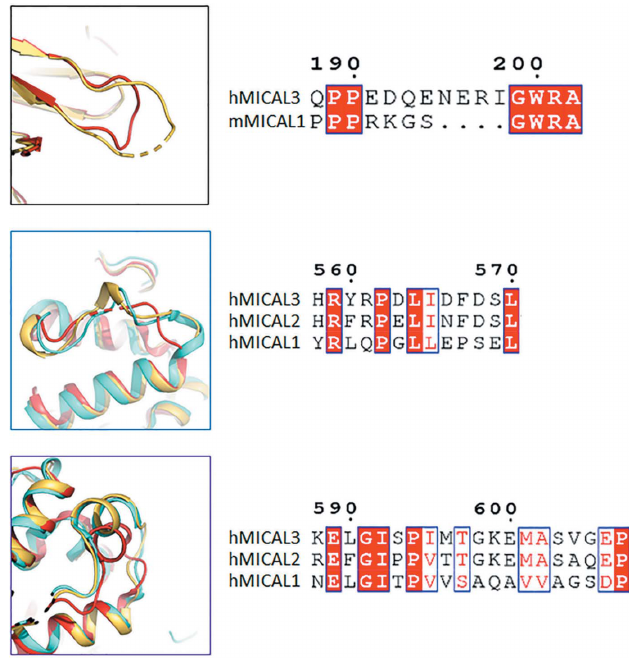
Figure 7 Comparison of the FMO domain and CH domain of MICALs from human and mouse. The sequence alignments between the MICALs are shown on the right for the comparison regions shown on the left. The boxes on the left have the same colors as those highlighting the corresponding sequences in Fig. 1. In the top left panel, the loop region of the FMO domain of human MICAL3 is in yellow and red indicates the FMO domain of mouse MICAL1 (PDB entry 4txi). The middle and bottom left panels show the superimposition of the CH domain of human MICAL3 in yellow, human MICAL2 (PDB entry 2e9k; RIKEN Structural Genomics/Proteomics Initiative, unpublished work) in cyan and human MICAL1 (PDB entry 2dk9; Sun et al. , 2006) in red.